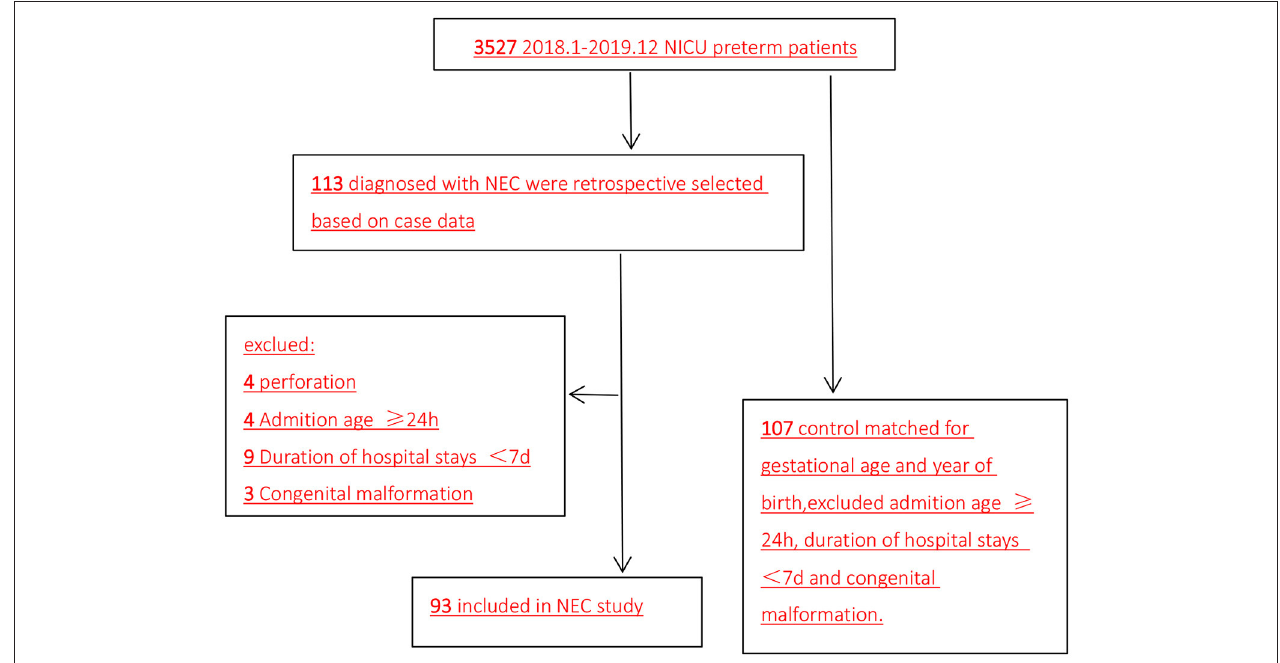
FIGURE 1 | Flow diagram of patient selection (2018.1–2019.12). NICU, neonatal intensive care unit; NEC, necrotizing